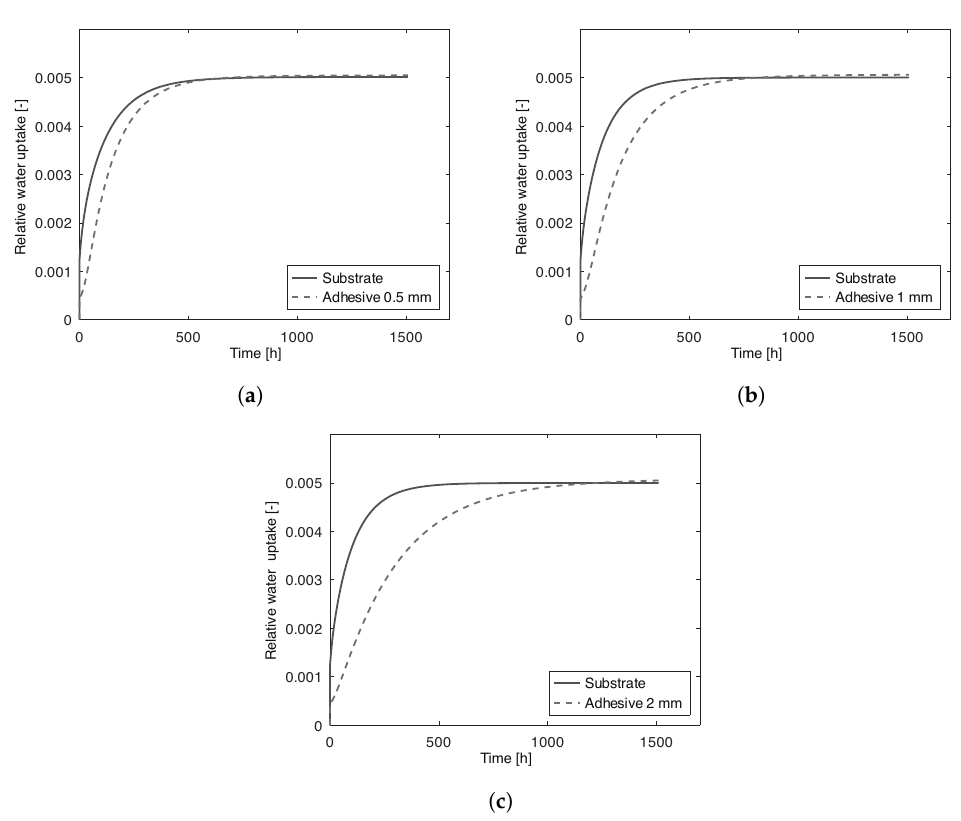
Figure 11. Numerical water uptake of adhesive and substrate of joints with 2 mm thick PBT-GF30 substrates and 0.5 mm ( a ), 1 mm ( b ), and 2 mm ( c ) thick adhesive.